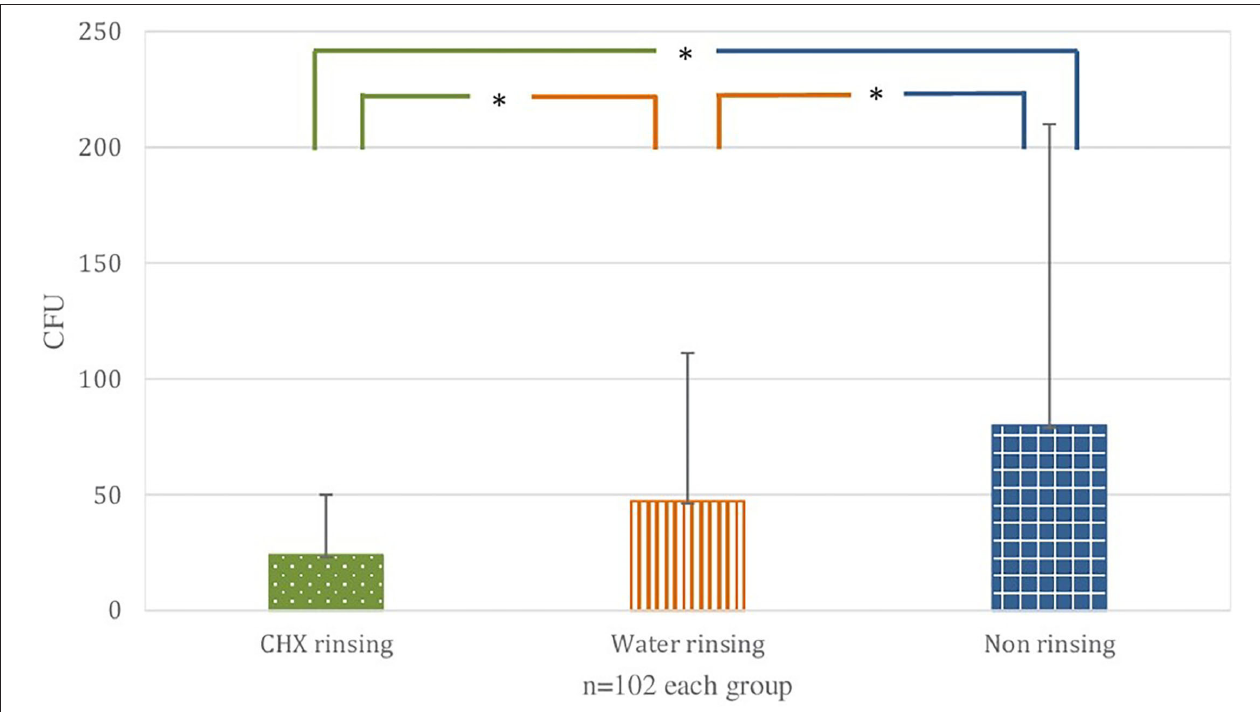
FIGURE 3 | Overall comparison. Bacterial load (colony forming units, CFU) on the surgical mask behind face shield in the three groups. The bars correspond to the mean value, the line on top to the ± standard deviation. Statistically significant differences ( p < 0.05) are marked with an asterisk.